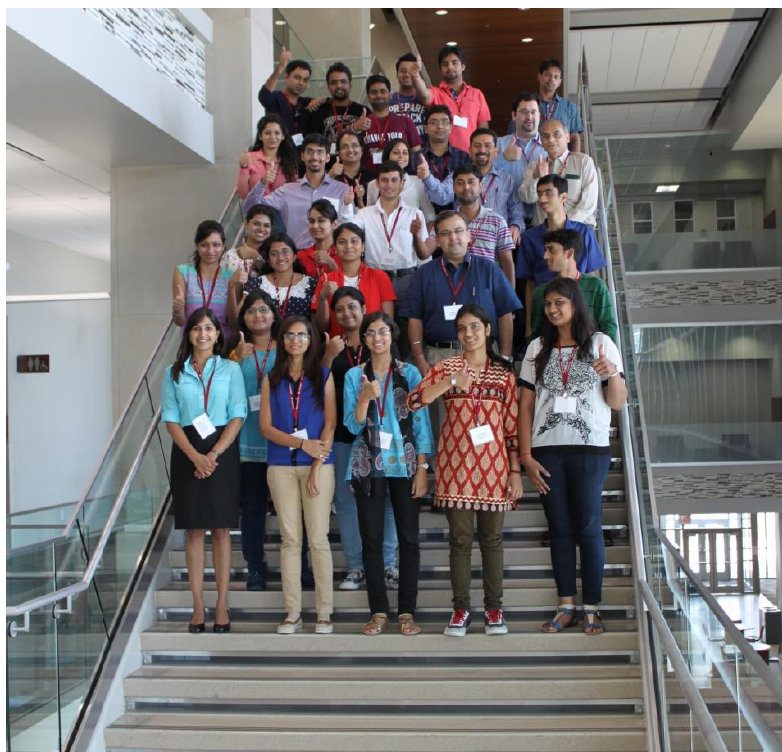
Figure 6. Faculty and students of AINST at Texas A&M University along with participants from eight other Indian institutes/universities for NSTS-2015 (Source: NSSPI